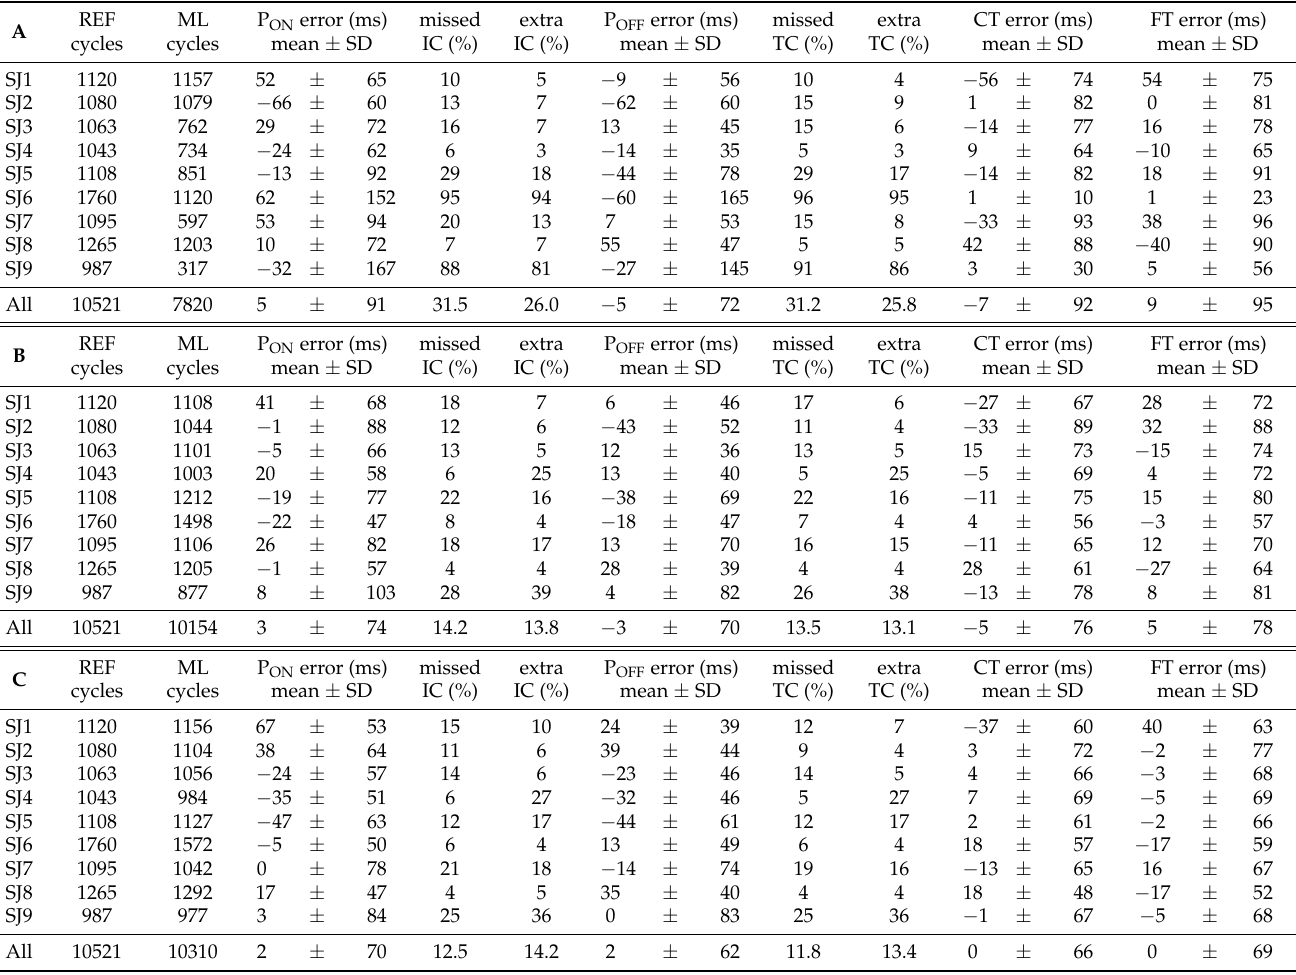
Table 2. Results for the parameters obtained for the skis, using the sensors placed on the sacrum ( A ), the sternum ( B ) and the upper back ( C ). Each row represents the training of the network on eight participants, which was tested on the remaining